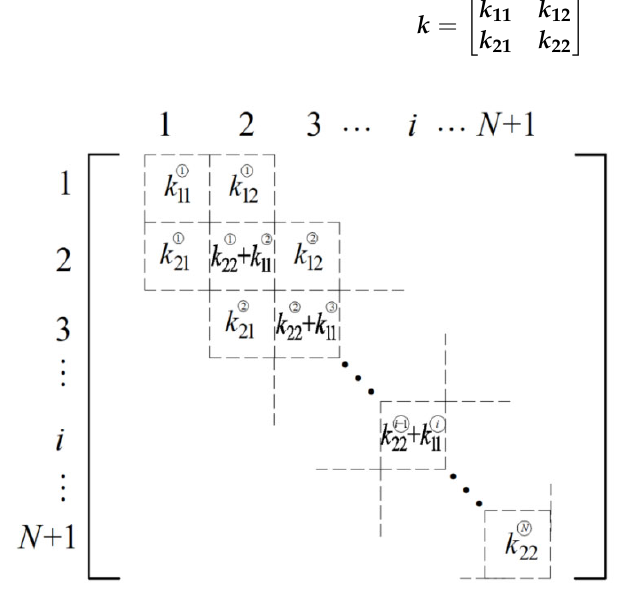
Figure A2. Global stiffness matrix of the pile.